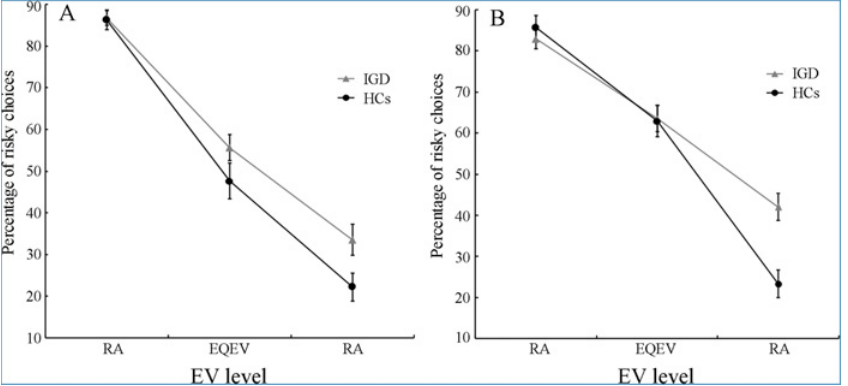
Figure 1. Decision-making performance for IGD subjects and HCs on the Cups task. Mean percentage of risky choices made in (A) the gain and (B) the loss domain, as a function of EV level and group. Error bars reflect standard errors. IGD = Internet gaming disorder; HCs = healthy controls; EV = expected value; RA = risk advantageous; EQEV = equal expected value; RD = risk disadvantageous.